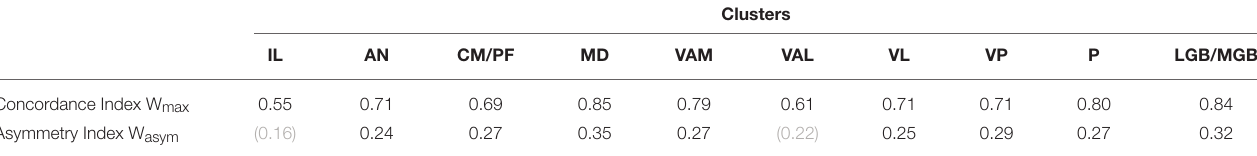
TABLE 2A | Cluster-level concordance.